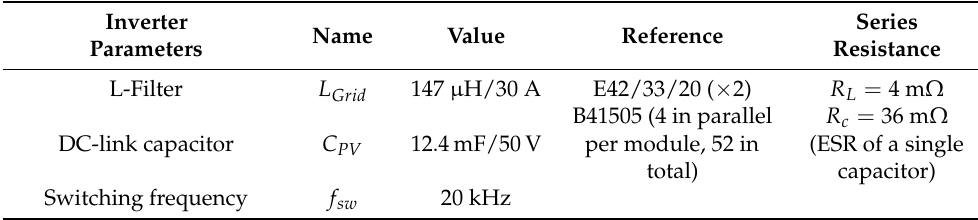
Table 6. Cascaded H-Bridge Multilevel Inverter